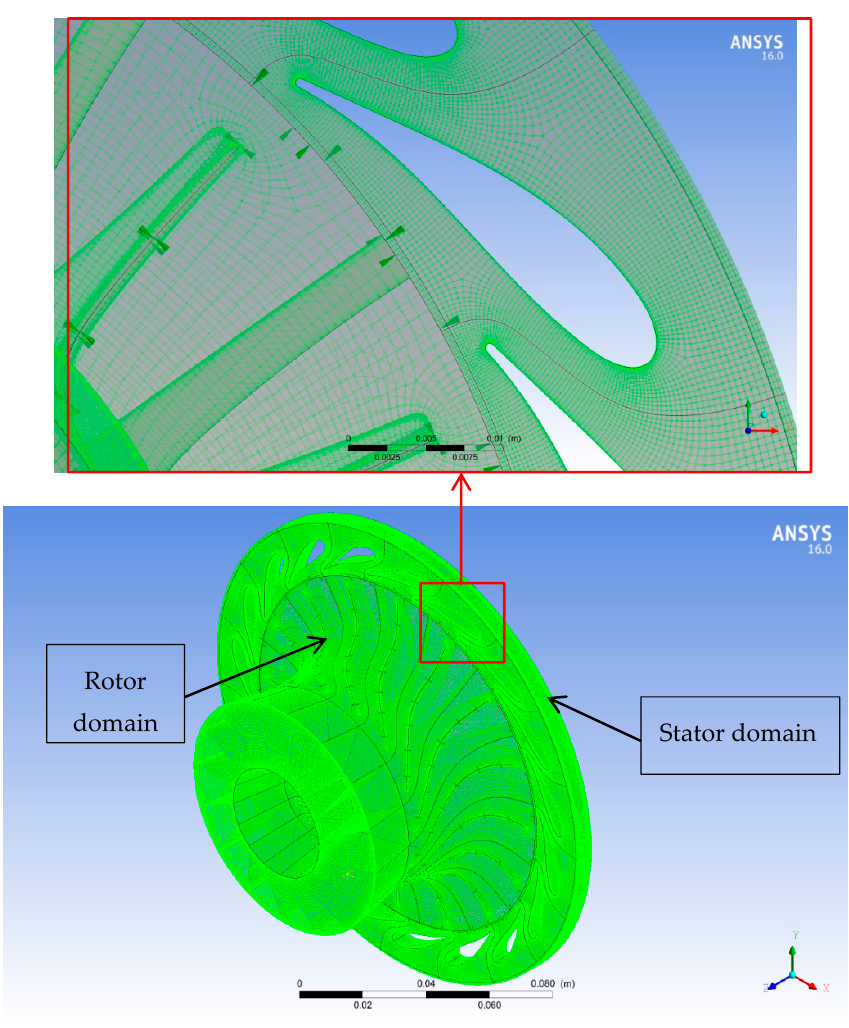
Figure 4. Computational meshes of the rotor and stator domains.